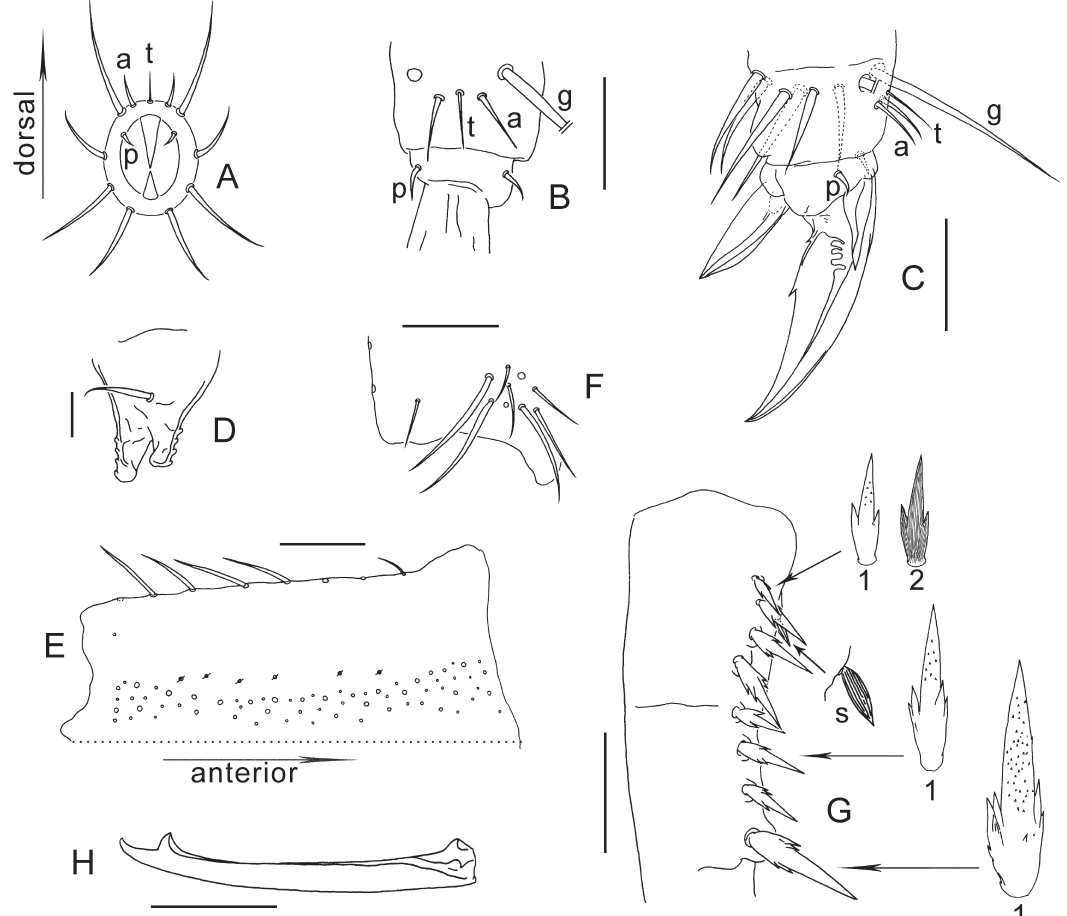
Fig. 5. Tomocerina annamitica sp. nov. A . Diagram of tibiotarsal distal chaetae (distal view). B . Tibiotarsal distal chaetae (dorsal view). C . Hind claw (lateral view). D . Tenaculum (anterior view). E . Left side of manubrium (dorsal view). F . Disto-external corner of manubrium (dorsal view). G . Basal and middle subsegments of dens with dental spines (dorsal view, 1 = ventral side of spine, showing only distal serrations; 2 = dorsal side of spine, showing fine longitudinal ribs; s = small inner scale). H . Mucro (inner view). Scale bars: B–D = 20 μm; E–H = 50